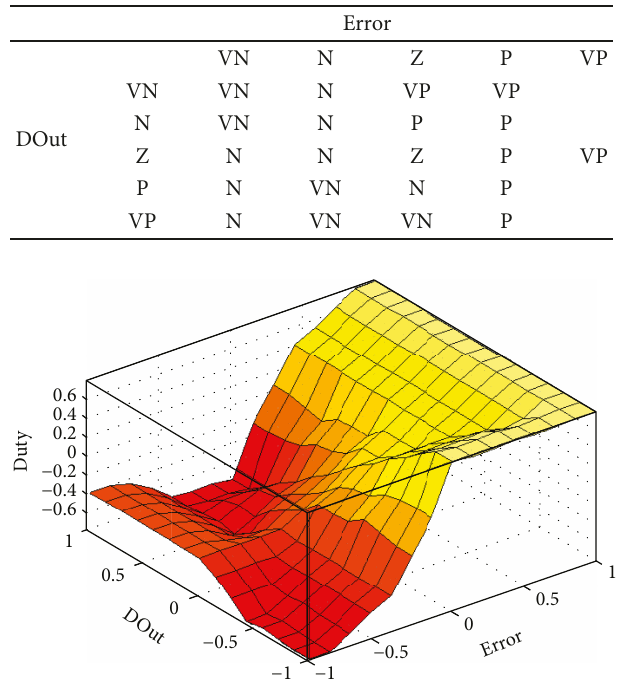
Figure 6: Relationship between the input and output variables of the FCS.